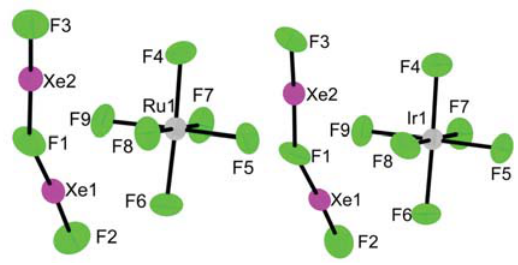
][ RuF ] and [ Xe F 2 3 6